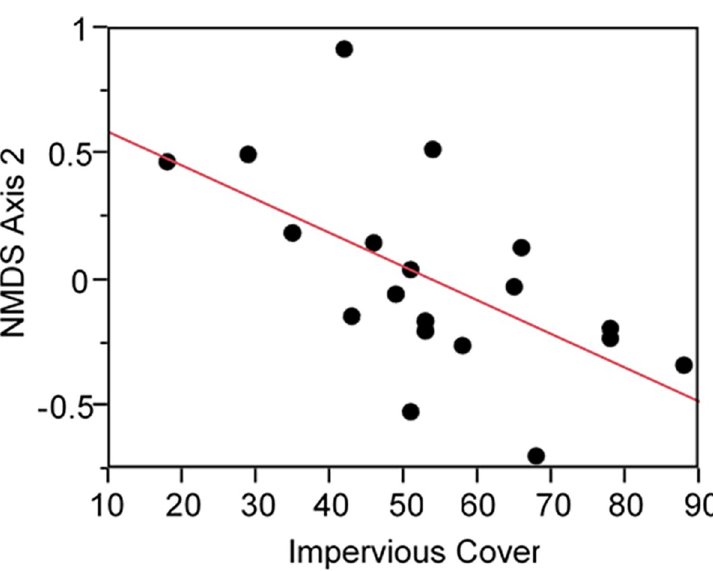
Fig 3. Linear regression showing the relationship between NMDS axis 2 and percent impervious cover. A significant negative correlation was found between bee community composition (NMDS axis 2) and impervious cover measured in the 500 m surrounding study sites (R 2 = 0.34; P = 0.0078).